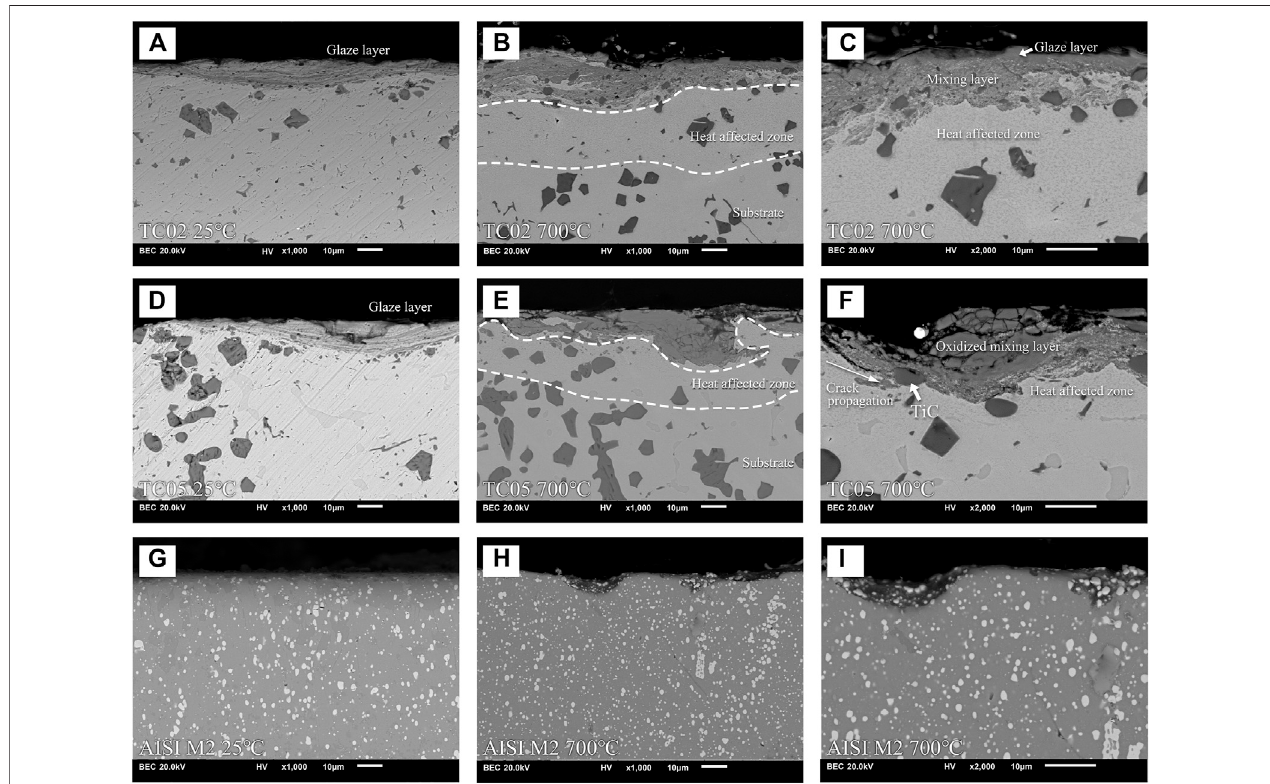
FIGURE 8 | Cross-sectional microstructure of the worn surface under 25 and 700 ° C: (A – C) are TC02 alloy; (D – F) are TC05 alloy; (G – I) are M2 steel.